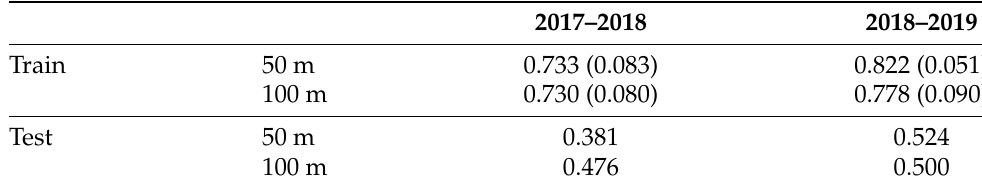
Figure 6. Variable importance from random forest classifications. ( a ) 2017–2018, 50-m radius, ( b ) 2017–2018, 100-m radius, ( c ) 2018–2019, 50-m radius and ( d ) 2018–2019, 100-m radius. References: Sub-indices 9 and 19 represent window sizes in Sentinel 2 pixels, i.e., ≈ 50 and 100 m radii; av, average; sd, standard deviation; ASM, angular second moment; Contr, contrast; Entr, entropy; IDM, inverse difference moment; intersp, interspertion; EVI, Enhanced Vegetation Index; LSWI, Land Surface Water Index; mode, most common land cover class; NDBI, Normalized Difference Built-up Index; NDVI, Normalized Difference Vegetation Index; NDWI_x, Normalized Difference Water Index by Xu; NDWI_mf, Normalized Difference Water Index by McFeters; Shannon, Shannon diversity index; Simpson, Simpson diversity index; rich, richness—number of different land cover classes. Table 4. Train and test overall accuracy for random forest classifications in different periods and using buffers of 50- and 100-m